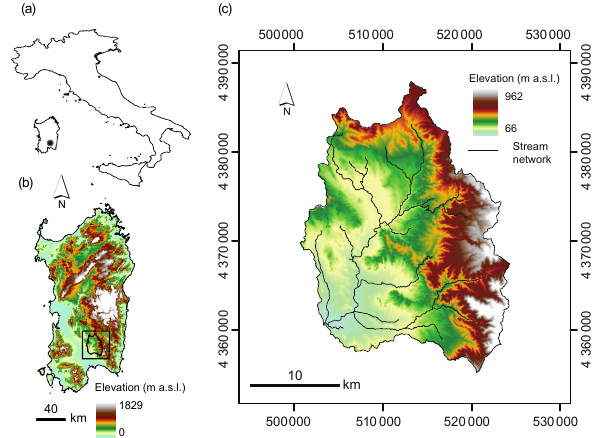
Figure 1. Location of the Rio Mannu basin within Italy (a) and Sardinia (b) . Boundaries in WGS84 UTM zone 32N coordinates, elevation, and stream network of the basin (c)